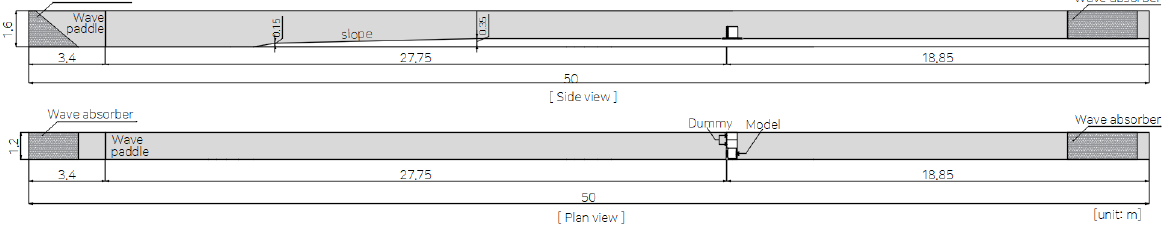
Figure 4. Side and plan views of the wave flume with the locations of the model and of the two dummy models.